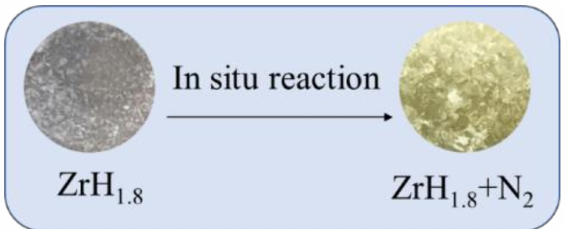
Figure 2. The appearance of the zirconium hydride sample before and after in situ reaction.